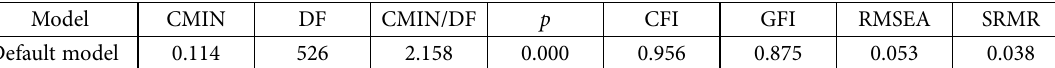
Table 8. Model fit data (source: compiled by authors 2020)